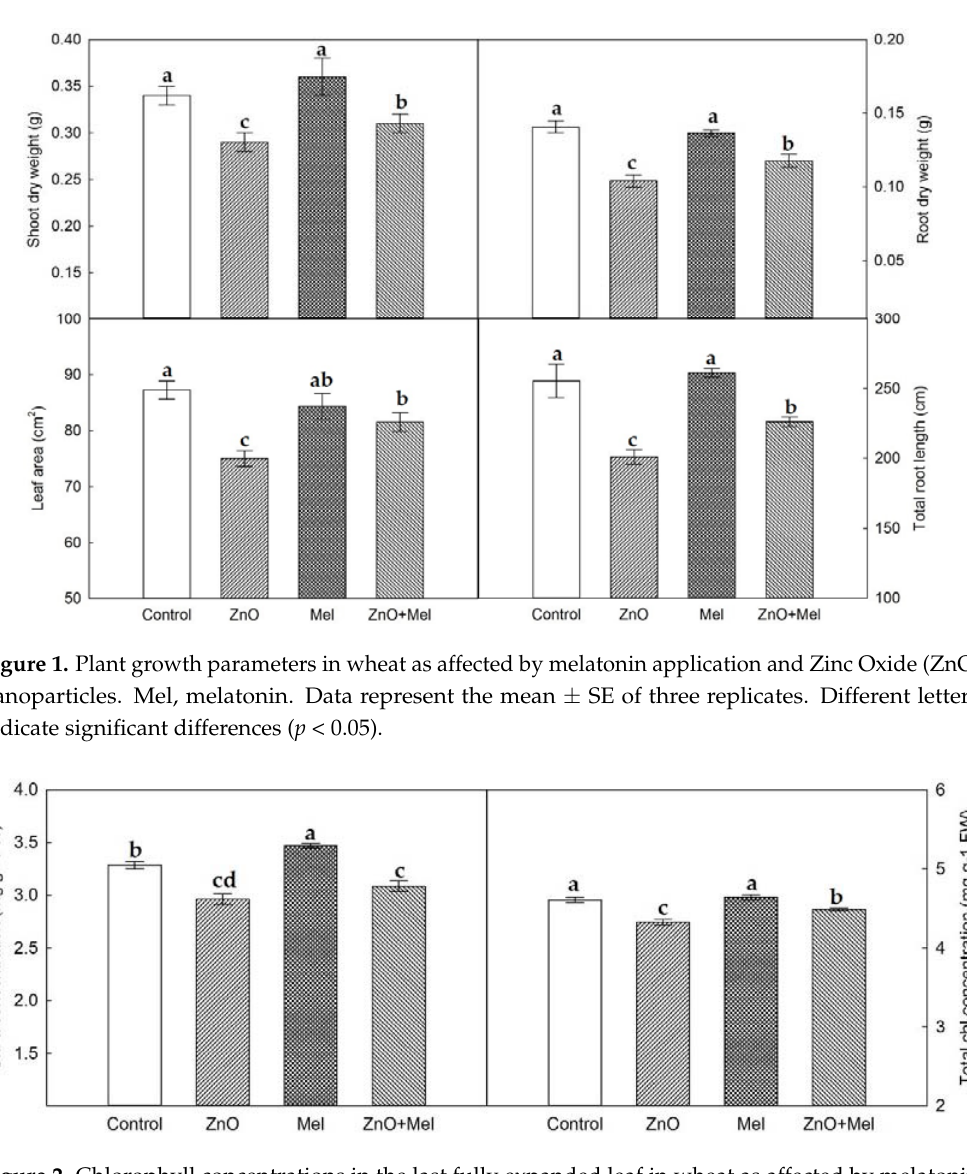
Figure 2. Chlorophyll concentrations in the last fully expanded leaf in wheat as affected by melatonin application and Zinc Oxide (ZnO) nanoparticles. Mel, melatonin. Data represent the mean ± SE of three replicates. Different letters indicate significant differences ( p < 0.05).